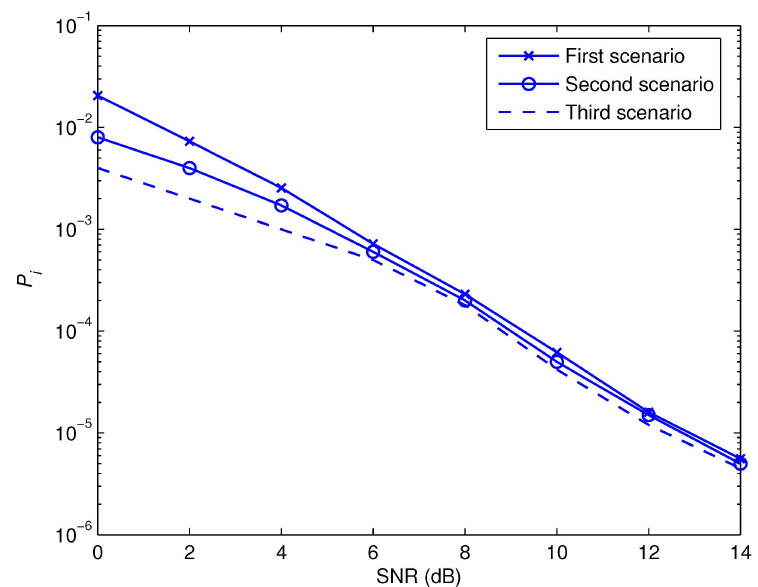
Figure 5. The identification performance at three scenarios. The system’s parameters are SNR = 14 dB, N = 2048, (cid:104) Φ ( u ) (cid:105) = 512, u = 0,1,2,3, ν = 11, χ = 60, 10 channel paths, convolutional codes of rate 0.5, interleaved sub-carrier mapping, STBC set of S1, S2, S3, S4, S5, and modulation set of 4-QAM,